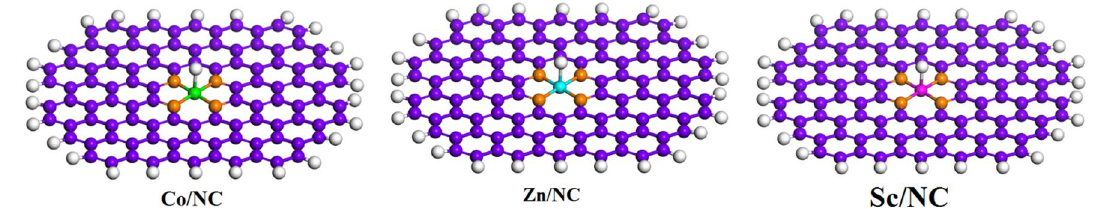
Figure 2. Optimized structures of H adsorption on the metal/NC: C, purple; H, white; N, orange; Co, green; Sc, pink; Zn, blue.